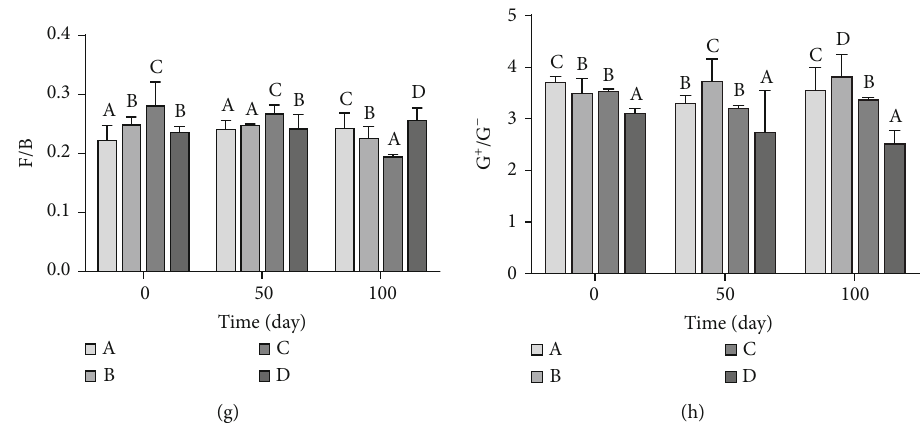
Figure 4: (a) Total phospholipid fatty acids; (b) bacterial; (c) Fungi; (d) G + , Gram-positive bacteria; (e) G – , Gram-negative bacteria; (f) Actinomycetes; (g) F/B, the ratio of fungi to bacteria; (h) G + /G – , the ratio of Gram-positive bacteria to Gram-negative bacteria for di ff erent treatments. Di ff erent letters above bars indicate signi fi cant di ff erences ( P < 0.05) at each sampling